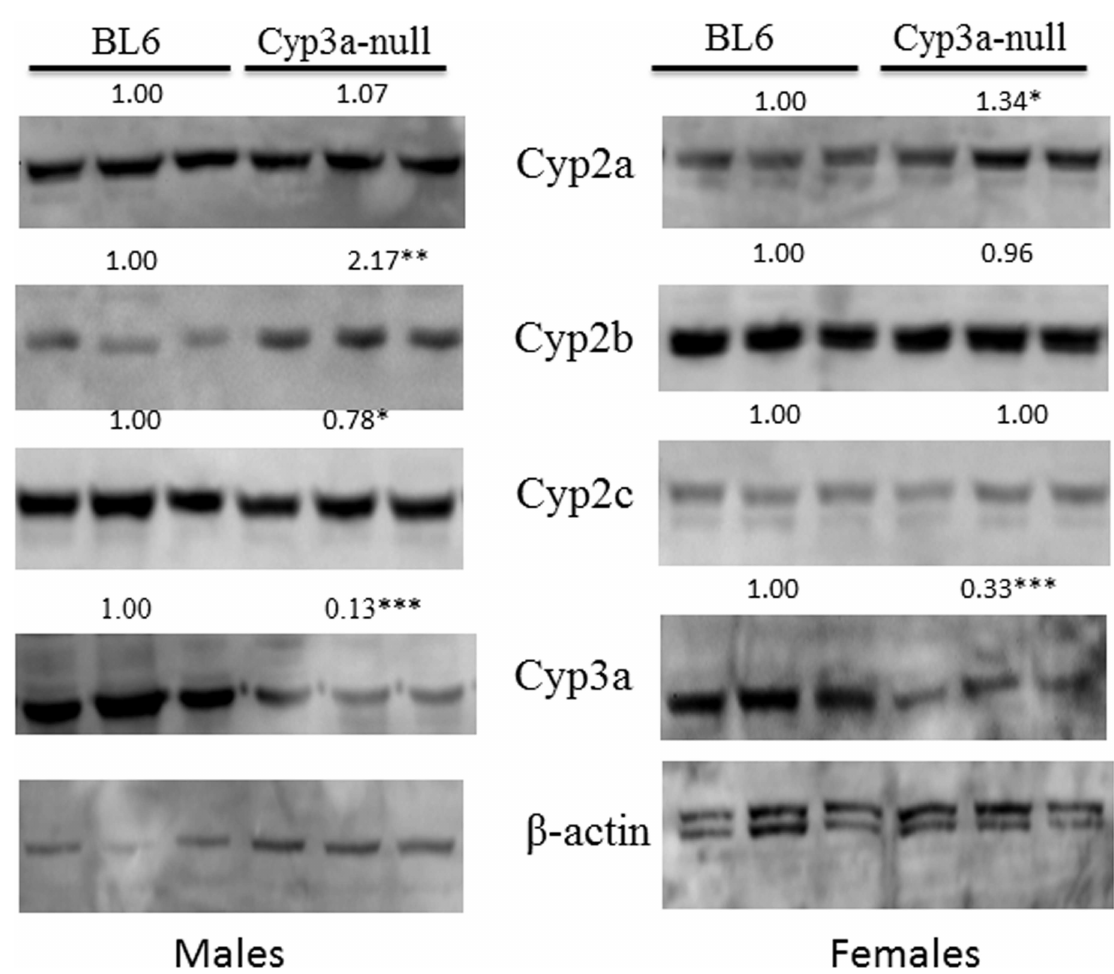
Fig 4. Compensatory changes in CYP protein expressionin Cyp3a-null mice. Western blots of male and female Cyp3a-null mice show significantchangesin CYP expressionrelative to their WT counterparts. Results are expressedas relative mean of the WT comparedto CAR-nullmice of the same sex. Statistical differenceswere determined by Student’st-tests (n = 3) with * (p < 0.05) ** (p < 0.01) *** (p < 0.001) indicatingsignificantdifferences.